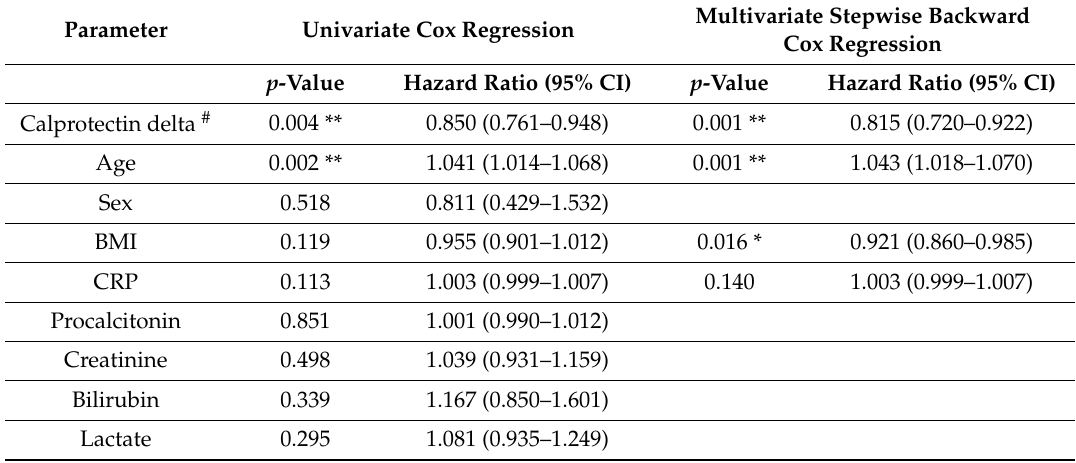
Table 3. Univariate and multivariate Cox regression analysis for the delta of calprotectin serum concentrations between day 1 and day 7 in critically ill